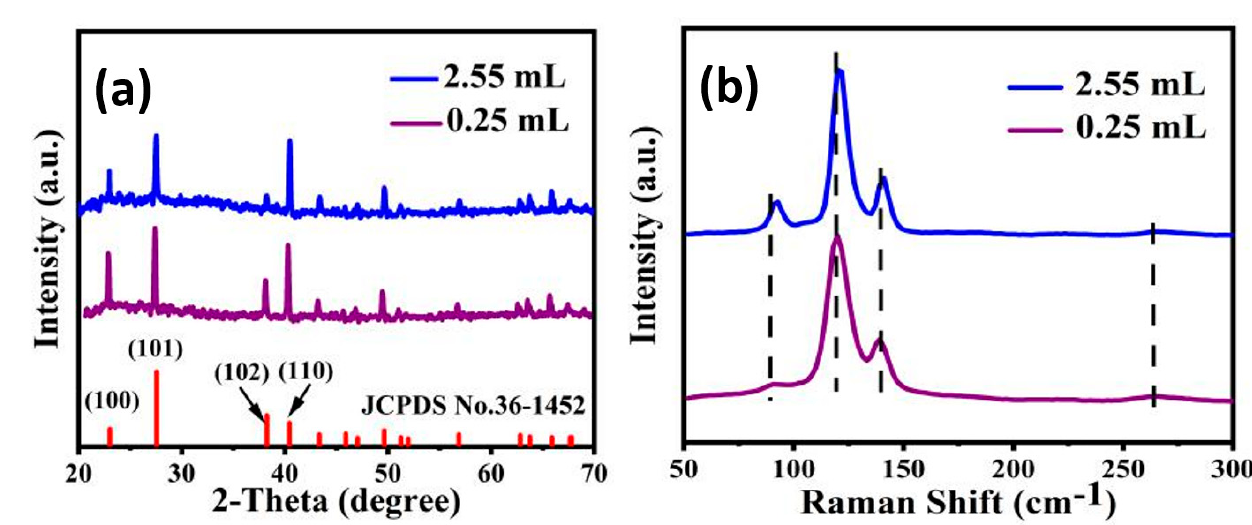
Figure 2. ( a ) XRD patterns and ( b ) Raman spectra of the as-prepared samples.